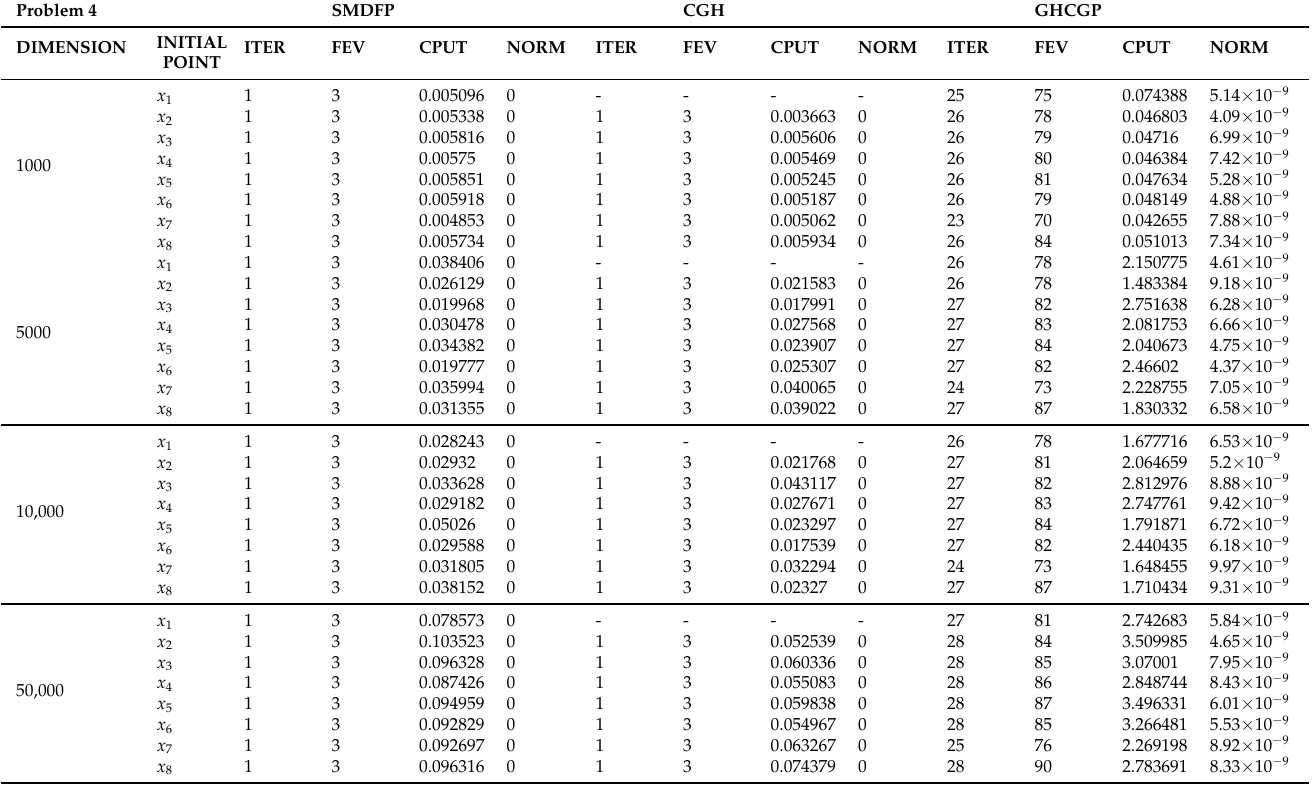
Table 4. Numerical comparison of the SMDFP, CGH [61], and GHCGP [62]